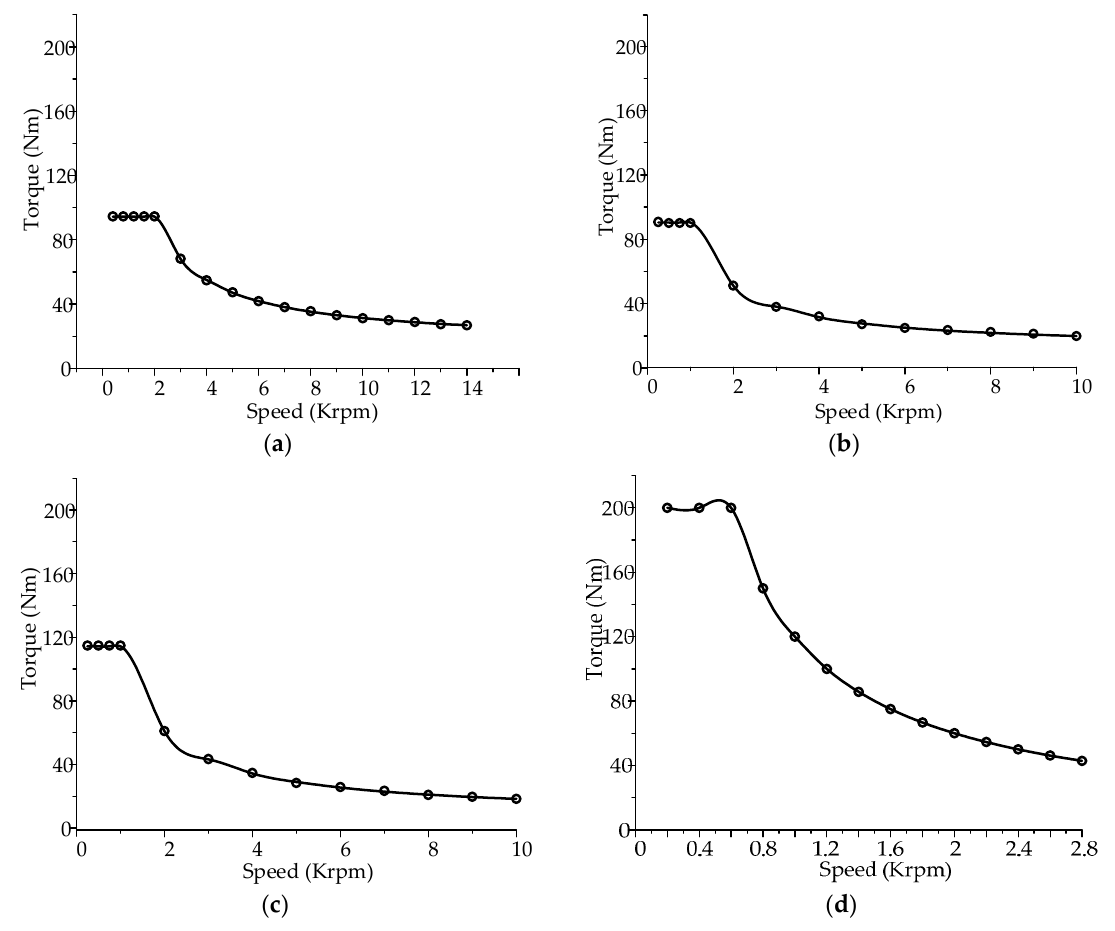
Figure 9. Torque-speed characteristic of proposed six-phase outer-rotor machines: ( a ) IPM type; ( b ) SPM type; ( c ) PMFS type; ( d ) PMV type.